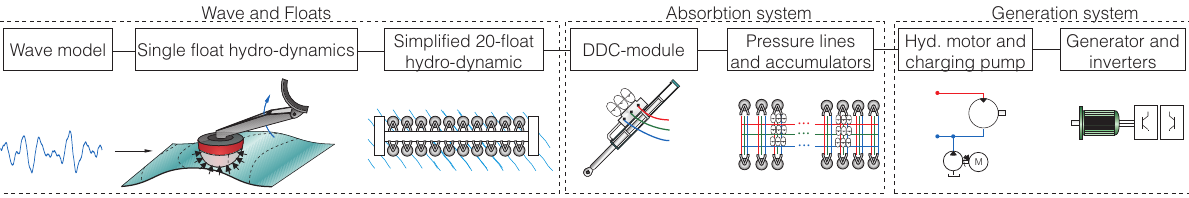
Figure 8. Modeled sub-systems of the Wavestar WEC and PTO system.